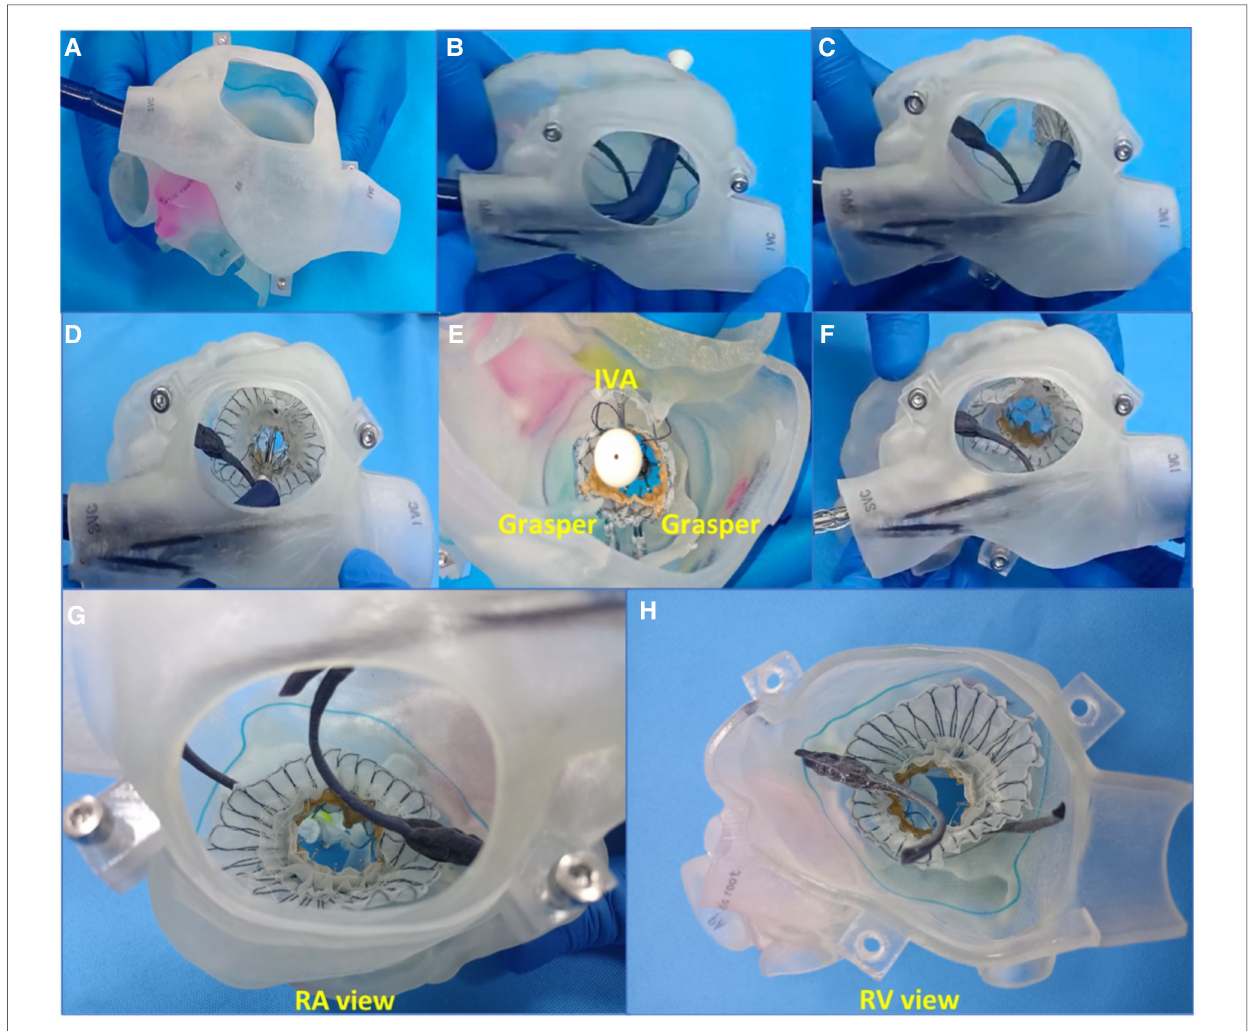
FIGURE 4 Simulation of TTVR using a 3D-printed model on the bench test (e.g., data for patient #6). ( A ) The delivery system was entered into the RA through the superior vena cava. ( B ) The delivery system was positioned to the TA, and the depth and coaxiality were adjusted. ( C ) The atrium disc began to be released. ( D ) The atrium disc was fully released. ( E ) IVA and two clamping keys were released in turn. ( F ) The delivery system was withdrawn. ( G ) RA view of TV after simulation. ( H ) RV view of TV after simulation. TTVR, transcatheter tricuspid valve replacement; RA, right atrium; TA, tricuspid annulus; RV, right ventricle; IVA, interventricular anchor; TV, tricuspid